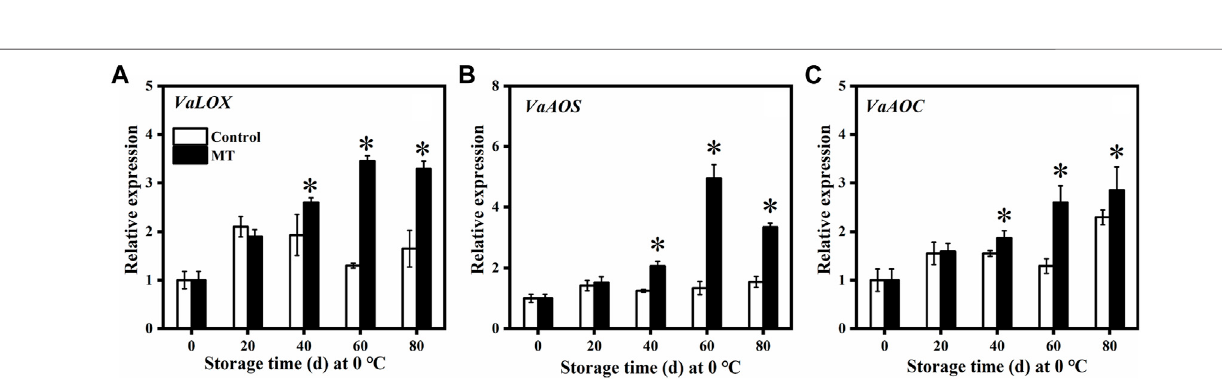
Frontiers in Chemistry |